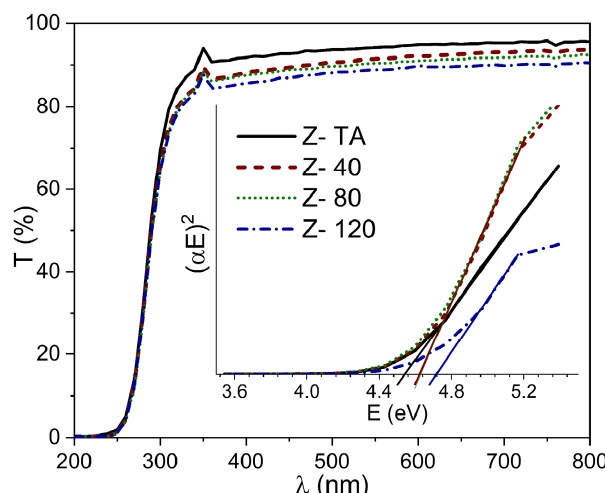
Figure 4. Transmittance spectra for thermally treated and UV-A treated ZrO 2 films indicate highly transparent films. The inset shows the Tauc plots, for all the samples, used to evaluate the energy band gap Eg of these films.